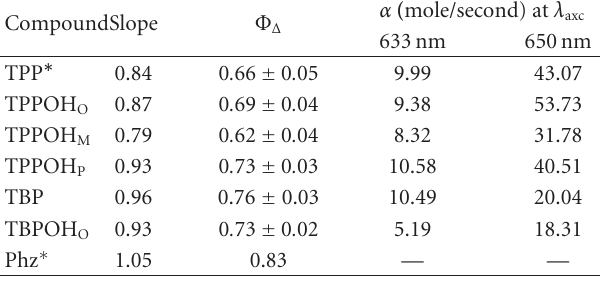
Table 4: Singlet oxygen quantum yields, Φ Δ , and photodynamic e ffi ciency, α , for the series of unsymmetrically substituted mesopor- phyrins in benzene for air equilibrated samples, at room tempera-